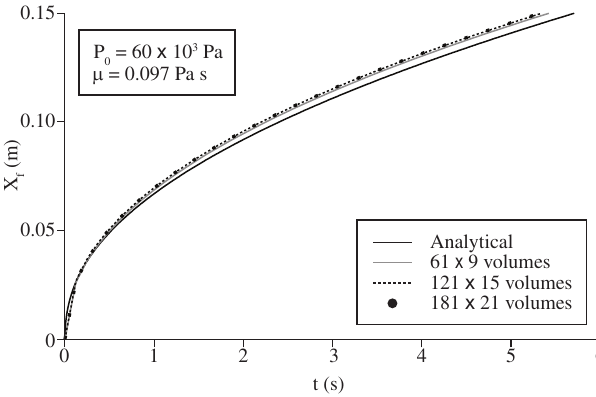
Figure 9. Comparison between numerical and analytical solutions for the orthotropic case.